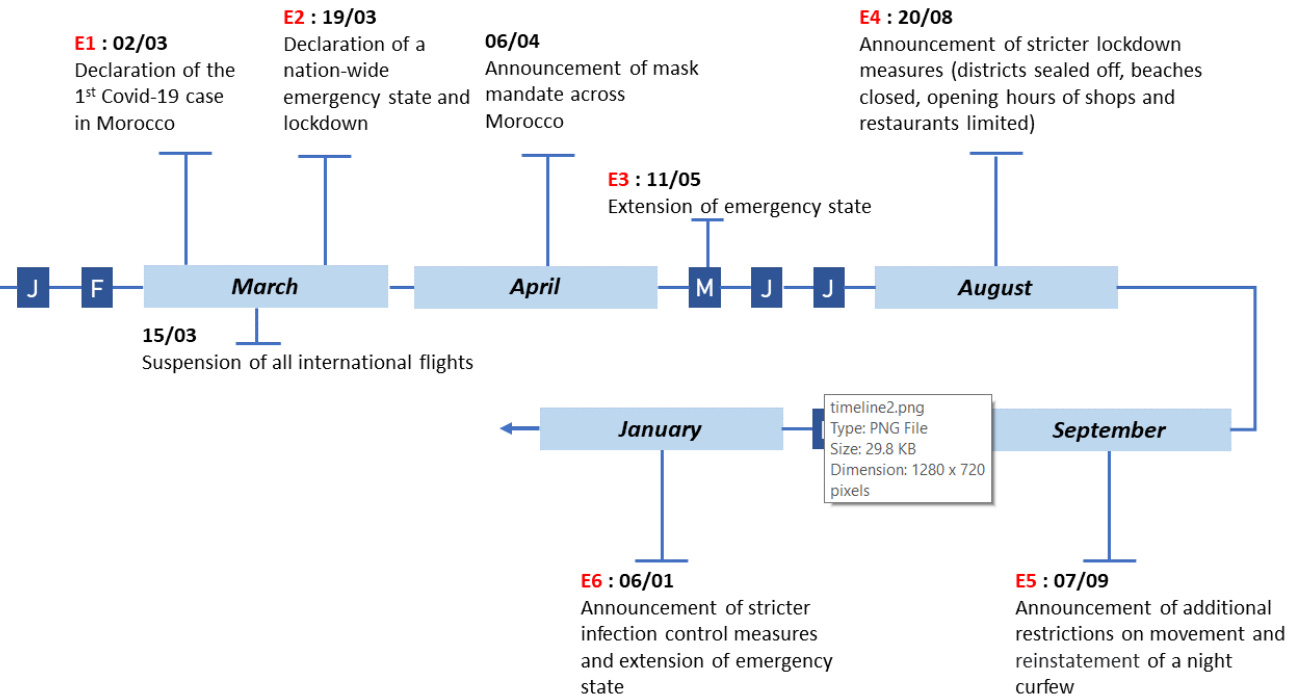
Figure 2. An excerpt of the timeline of COVID-19 related events in